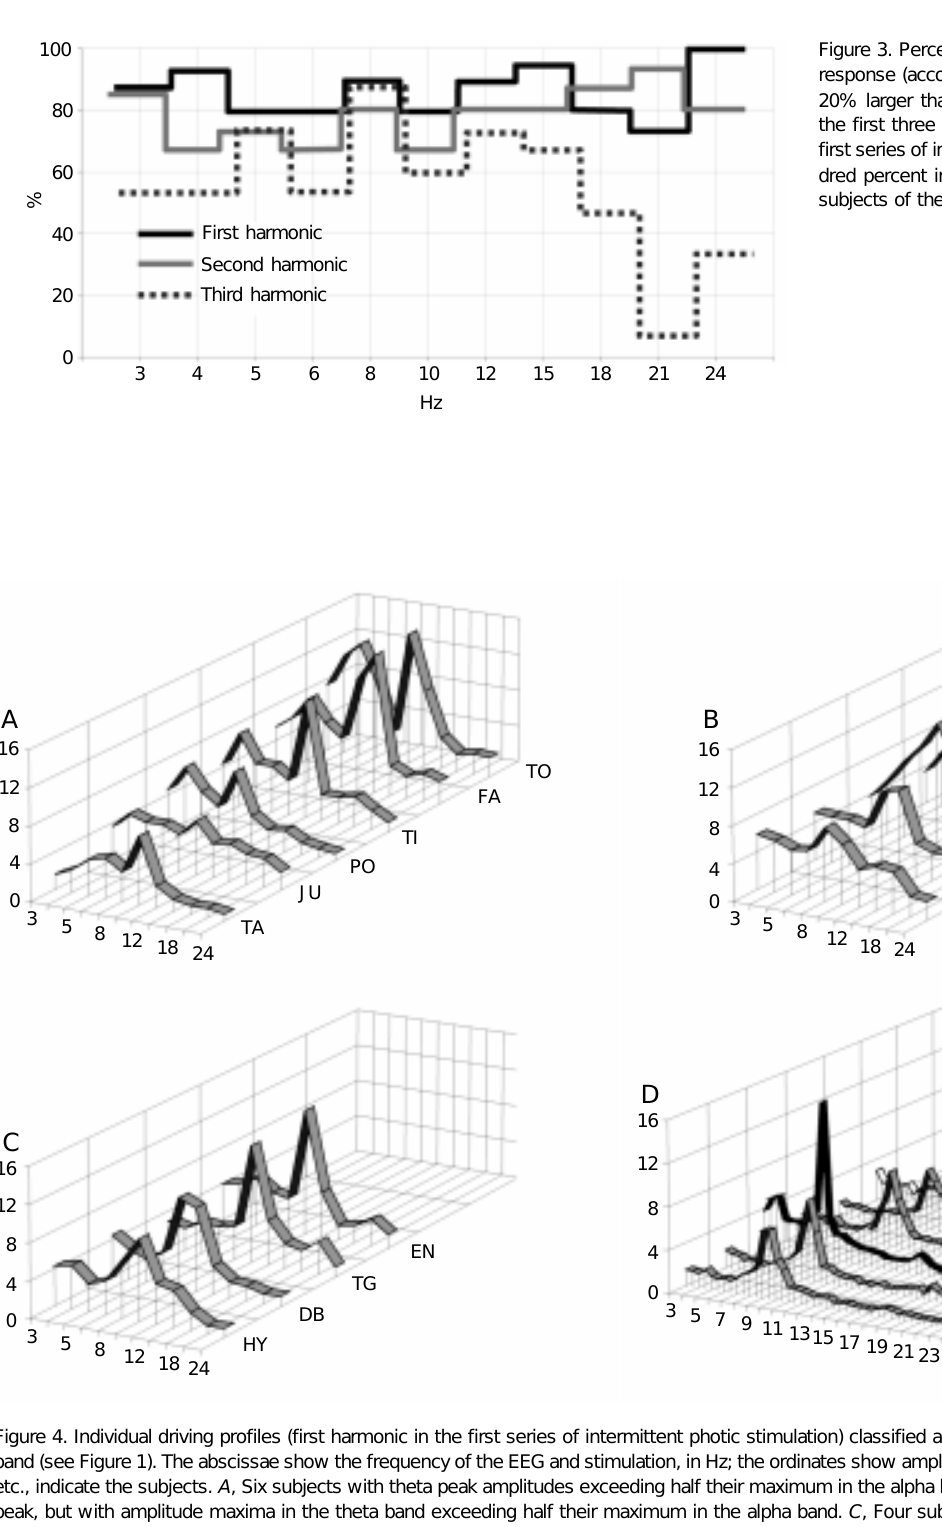
(cid:214) Hz. TA, JU, PO,